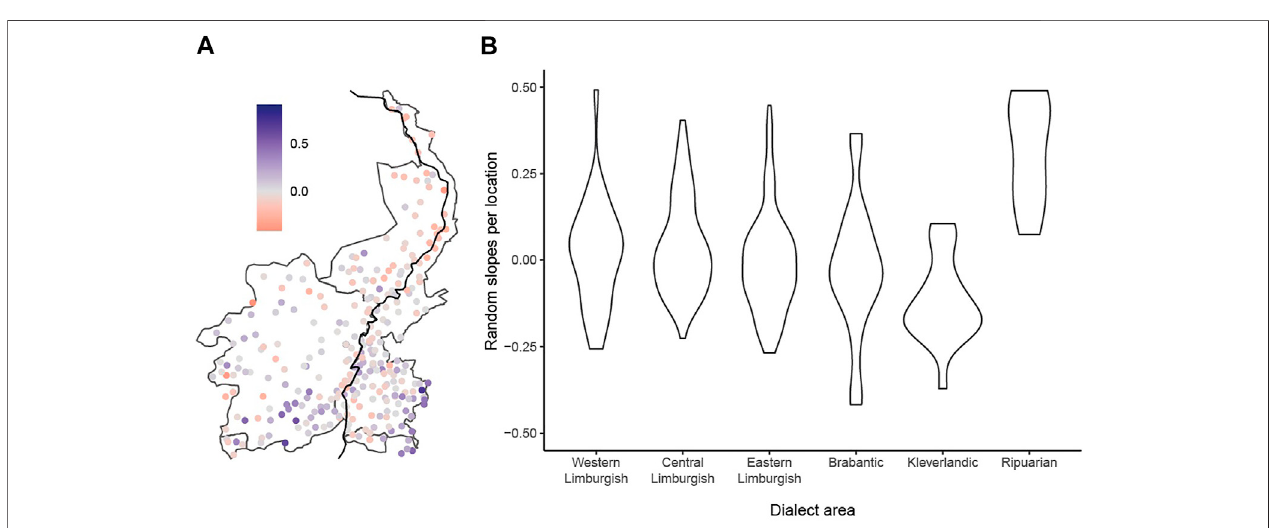
FIGURE 6 | Map showing the Limburgish area with values of the mean random intercept for each location (A) , and distribution of random intercepts across six dialect areas (B)